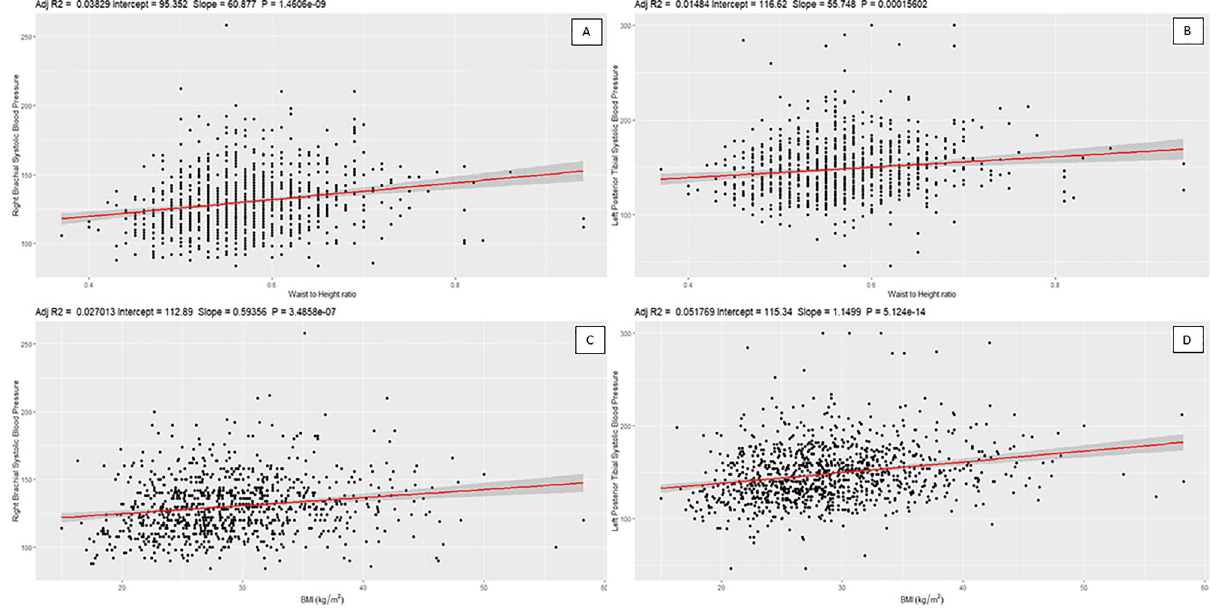
Figure 2. Four examples of linear regressions used. The top panels show the correlation between the right brachial ( A ) and the left posterior tibial ( B ) against the waist to height ratio. The bottom panels show the correlation between the right brachial ( C ) and the left posterior tibial ( D ) against the body mass index (BMI). Each black dot represents an individual result, with the red line showing the line of best fit and the grey area surrounding this showing a small 95% confidence interval of where the true line lies. On each graph, the adjusted R2 value is shown, along with the y-intercept, the slope gradient, and the P value of the association. These two specific systolic blood pressures were chosen as an example due to their statistical significance in all models.